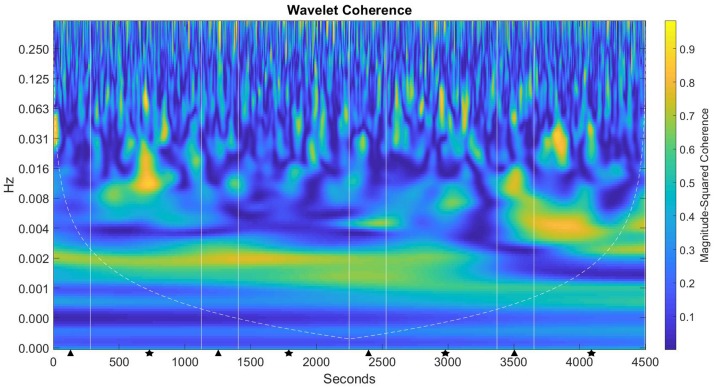
Magnitude-squared coherence plot for the CCM group. The left axis is the frequency of coherent activity in Hz; the bottom axis is time (s). Straight lines denote task cycles with decision (triangle) – monitoring (star), shaded contours represent areas of coherent activity of greater than 95% confidence.